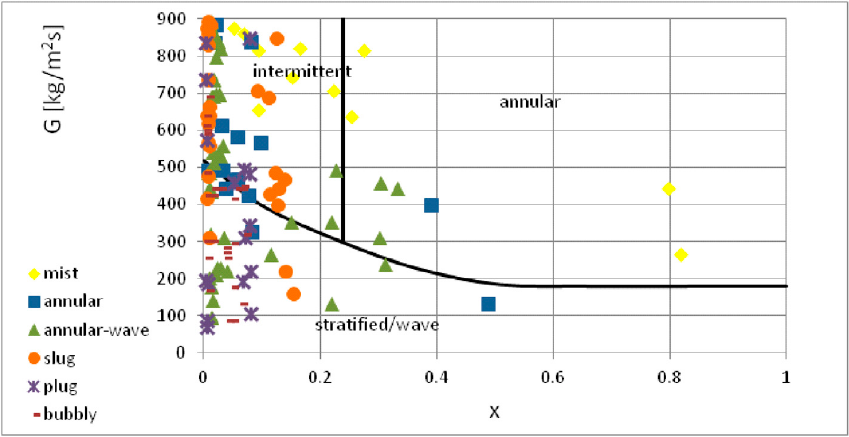
Figure 20. Comparison of the author’s experimental research results with the map of two ‐ phase flow structures according to map of Olivier et al. [41].